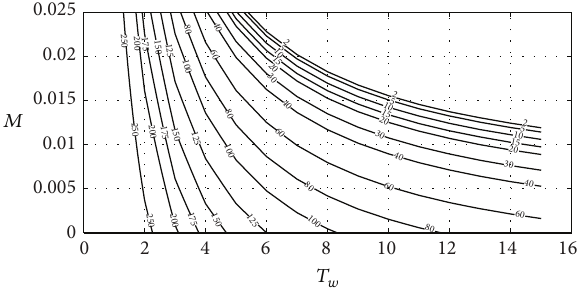
Figure 9: Relation between 𝑀 , 𝑇 𝑤 and 𝑘 𝑝